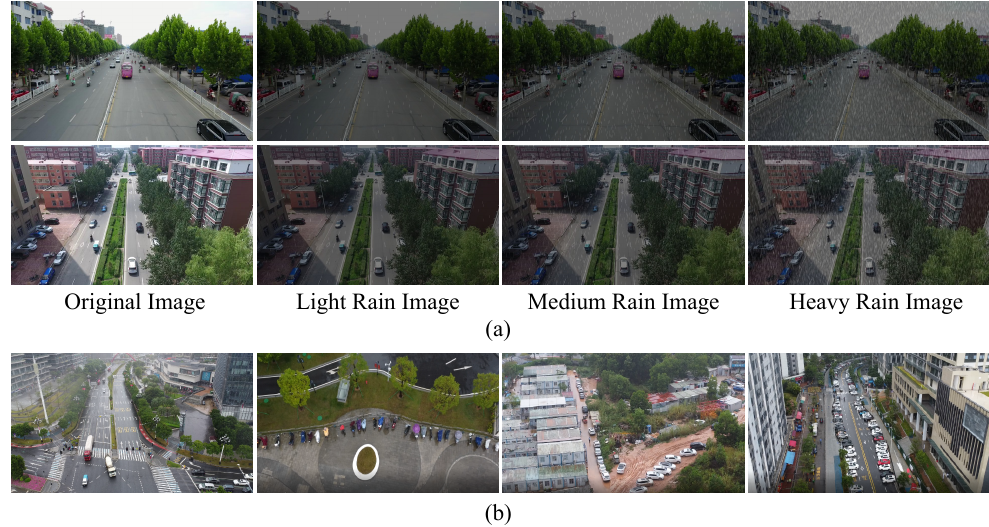
Figure 5. Samples of images from our datasets. ( a ) Synthetic rainy images from RainVisDrone and RainUAVDT. ( b ) Real rainy images from